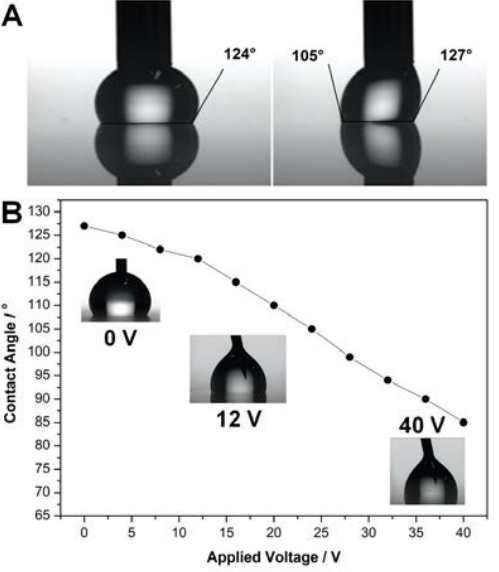
Figure 6. Surface wettability of PFMA dielectric layer: static and dynamic water contact angles ( A ), and the contact angle variation in applied electric field ( B ).